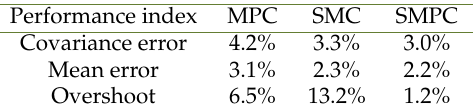
Table 2. Comparison of MPC, SMC, and SMPC performance indicators.